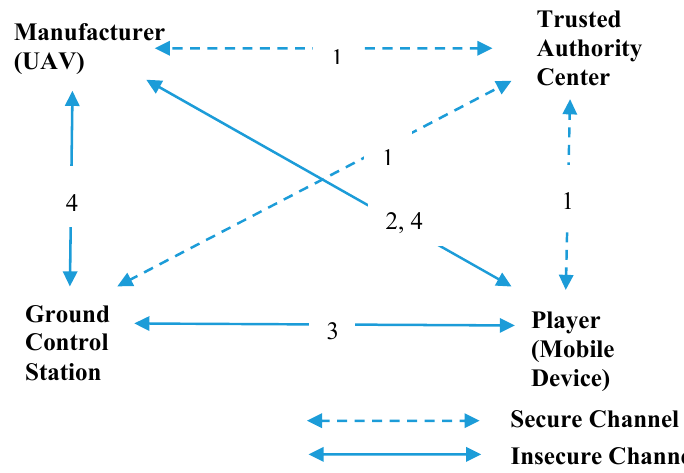
Figure Figure 1. The framework of a traceable and privacy-preserving authentication for UAV ad hoc communication.